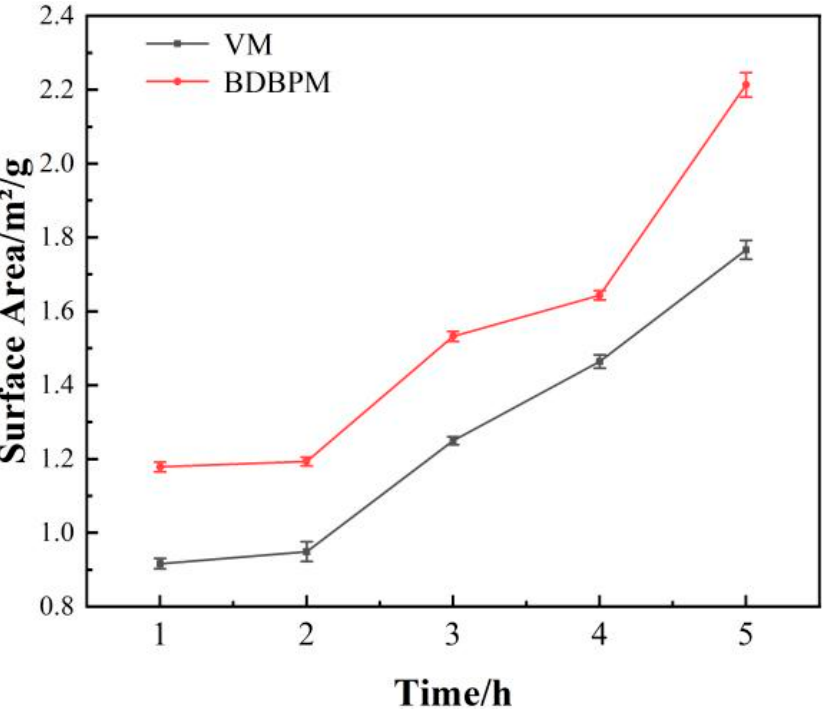
Figure 2. Surface area of Al 2 O 3 powder after different milling times.